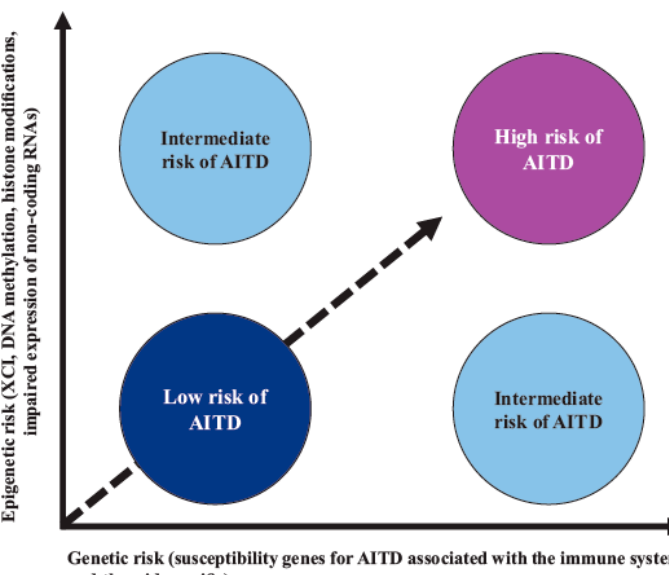
Figure 3. Interaction between genetic susceptibility and epigenetic factors in AITD. Genetic risk by itself confers a low-moderate risk for AITD; however, risk is increased when there is synergy with epigenetic modi fi cations of regulatory regions that are capable of controlling gene expression. Abbreviations: AITD: autoimmune thyroid disease, XCI: X-chromosome inactivation.